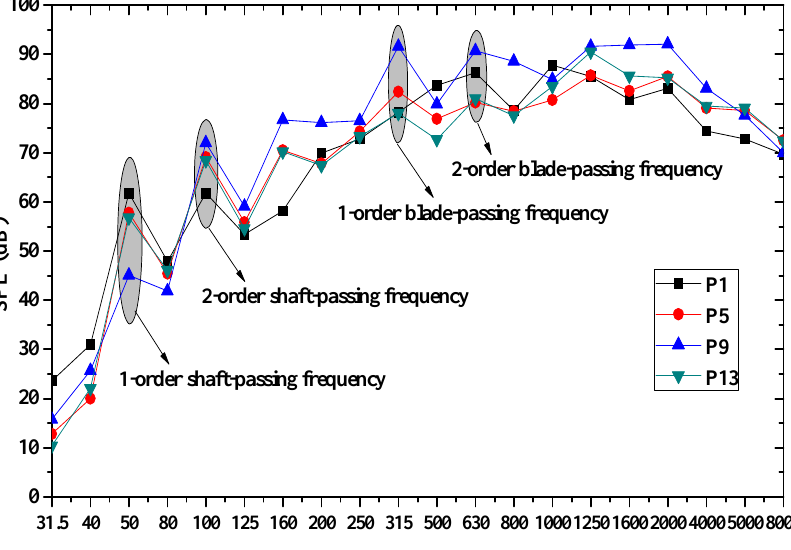
Figure 3. Changes in sound pressure level (SPL) at different monitoring points in a wide frequency range (2900 rpm). Appl. Sci. 2018 , 8 , x FOR PEER REVIEW